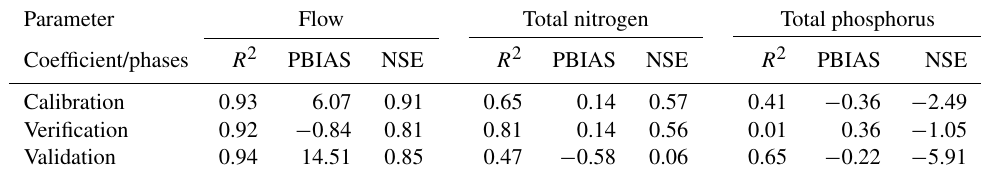
Table 5. The results of the calibration, verification and validation for flow, total nitrogen and total phosphorus.